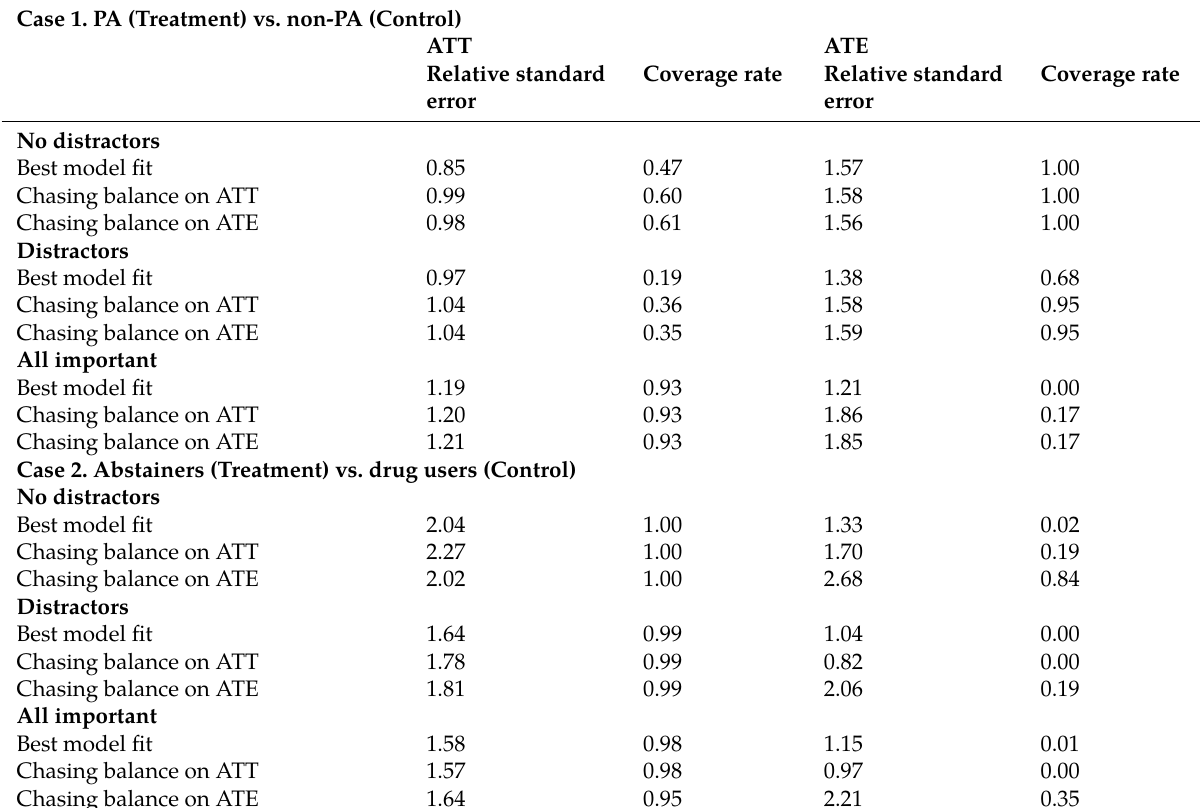
Table 2: Summary statistics for standard errors and inferences all cases and methods. Case 1. PA (Treatment) vs. non-PA